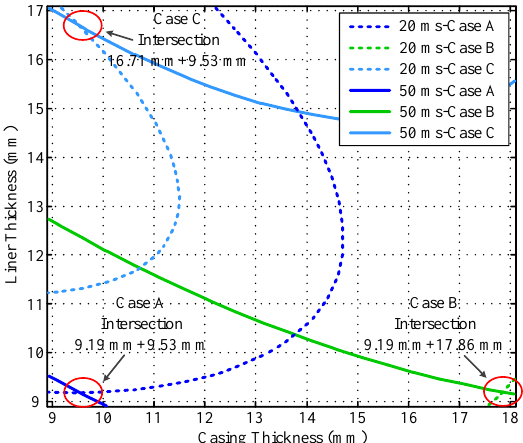
Figure 4. Intersection of induced EMF contour curves at 20 and 50 ms.